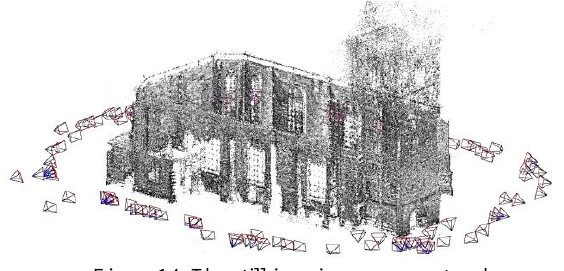
Figure 14. The still imaging camera network